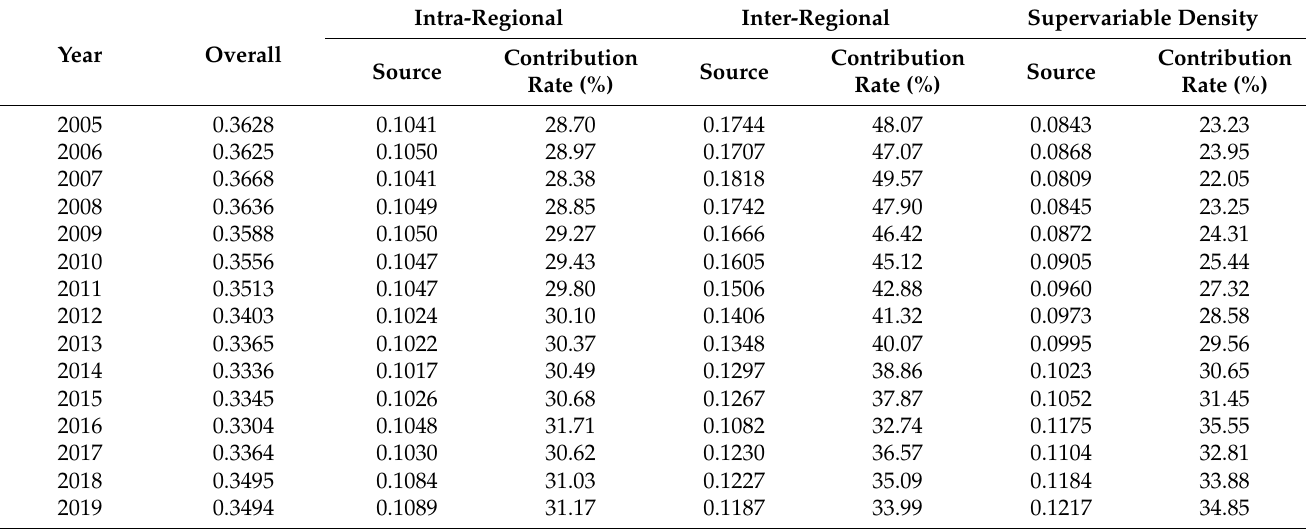
Table 3. Gini coefficient of carbon emission quantity from urban production energy